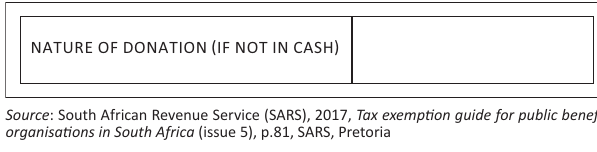
FIG URE 1: Extract from example provided by South African Revenue Service.